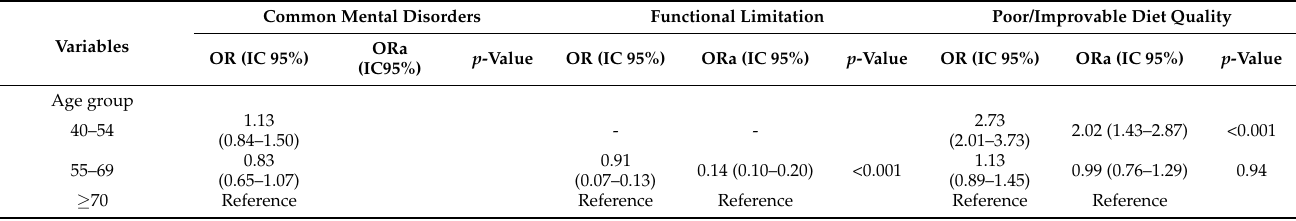
Table 5. Association between CMDs, functional limitation and poor/improvable diet quality and sociodemographic factors, health-related determinants and use of clinical preventive care services in women with COPD ( n =